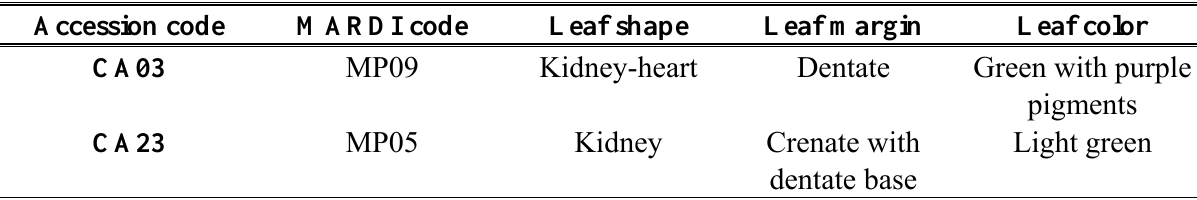
Table 1. Leaf morphological characteristics (shape, margin and colour) of two accessions of C.